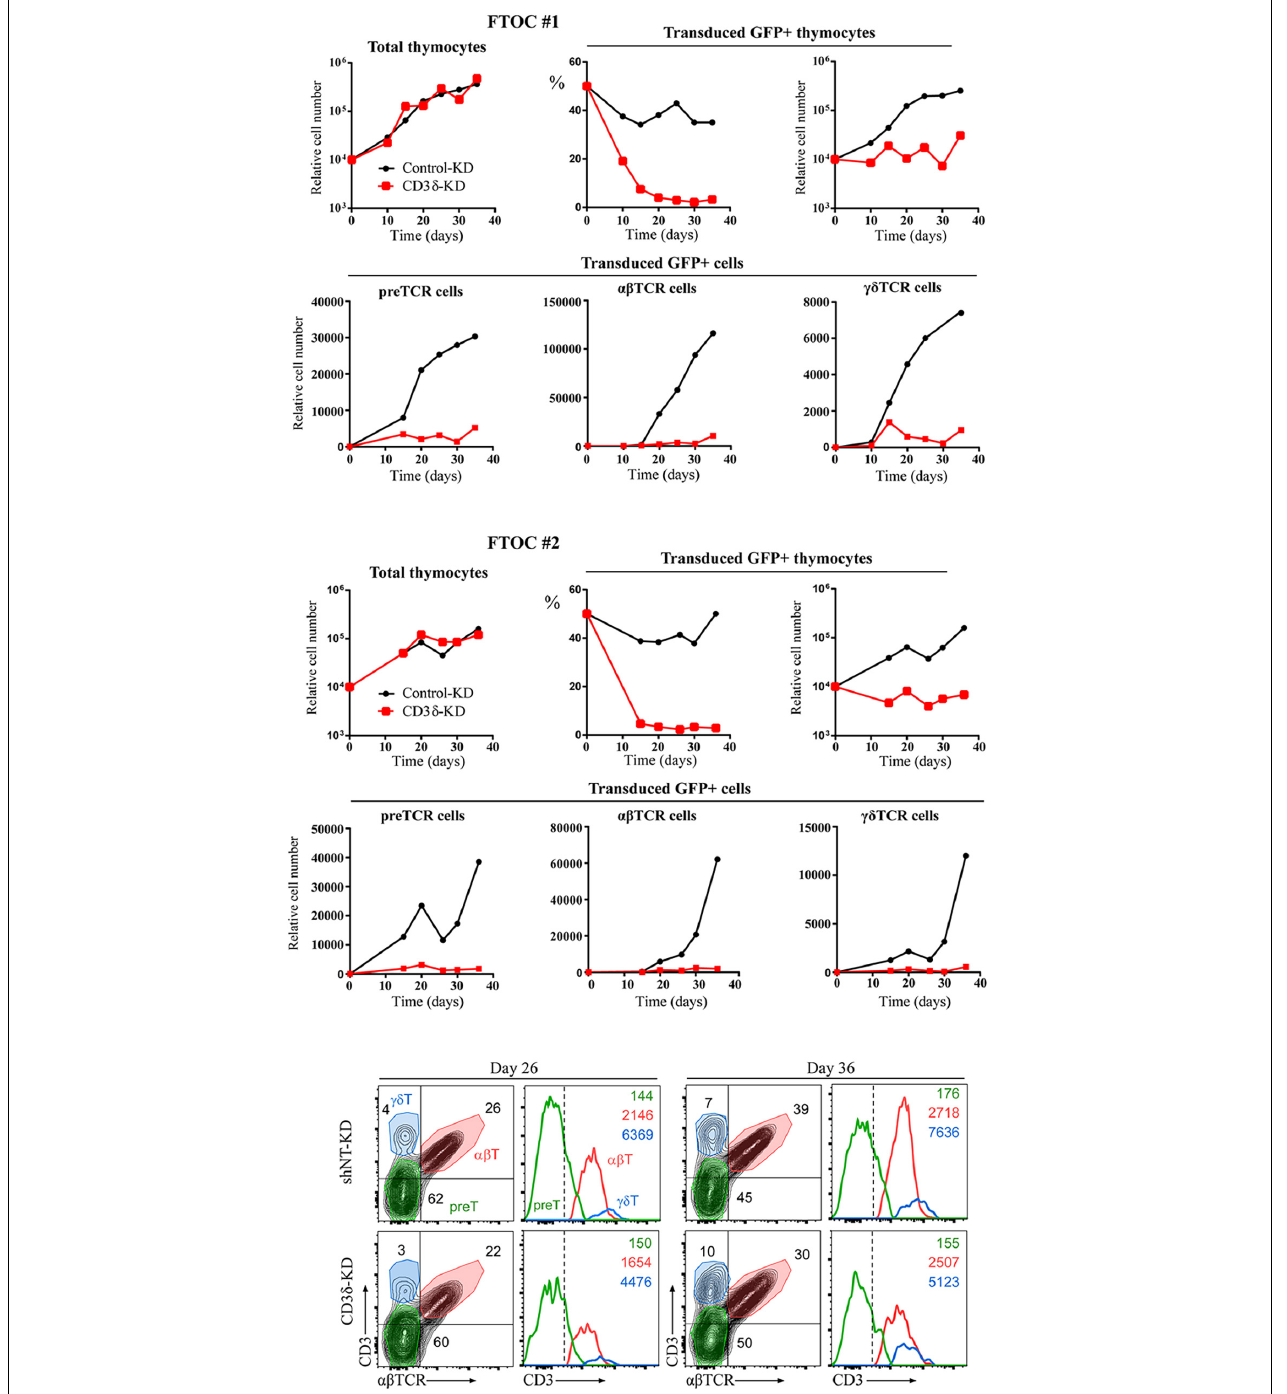
FIGURE 9 | Fetal thymus organ cultures (FTOC) of shCD3 δ -3 vs. shNT-transduced human T-cell progenitors. Top and middle: mouse embryo thymic lobes were seeded with shCD3 δ -3 or shNT-transduced CD34 hi early T-cell progenitors from human thymus and cultured for up to 5 weeks. T-cell generation was analyzed on electronically gated GFP + transduced cells recovered from different lobes pooled at the indicated time points in two independent experiments. Bottom: representative (FTOC 2) flow cytometry analysis of CD3 vs. αβ TCR expression on electronically gated GFP + cell progenies at the indicated days. Numbers in biparametric histograms indicate percentages of CD3 + αβ TCR + ( αβ T cells), CD3 − /low αβ TCR − (including pre-TCR + pre-T cells) and CD3 + αβ TCR − ( γδ T cells). Percentages of γδ T cells were independently confirmed by CD3 vs. γδ TCR expression analysis. Numbers in monoparametric histograms indicate MFI values for each indicated subset.